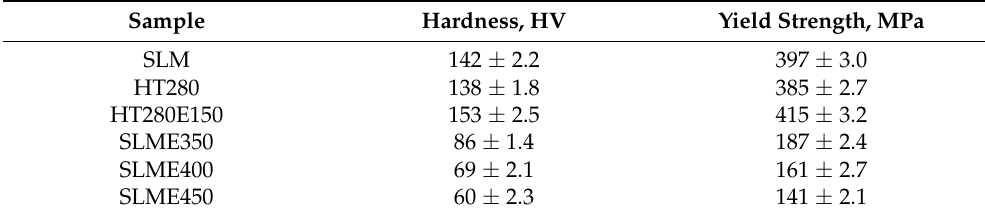
Table 3. Summary of mechanical properties obtained from hardness and compression